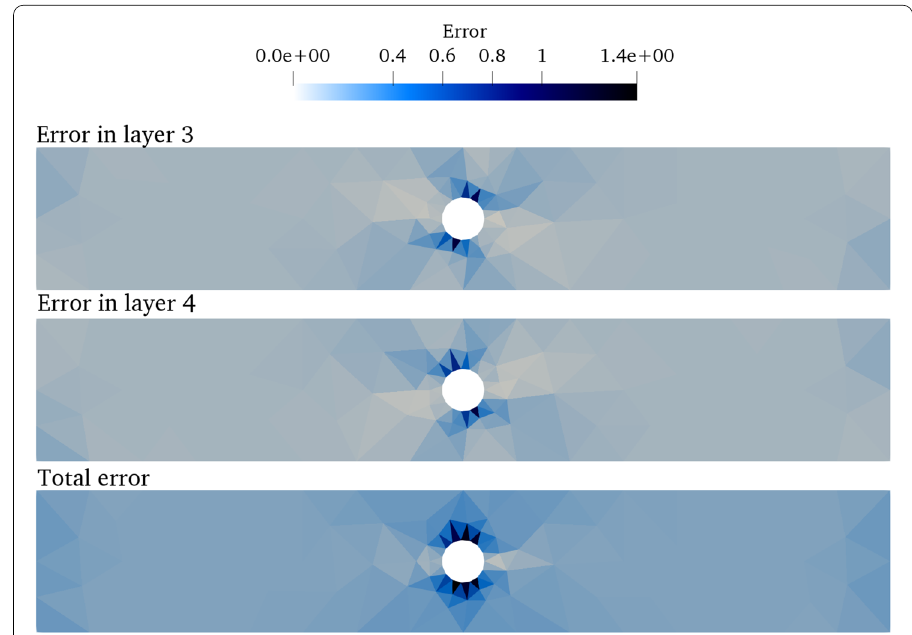
Fig. 12 Error indicator maps in layers 3 and 4 (top and middle) and total error for all layers (bottom) on the initial mesh